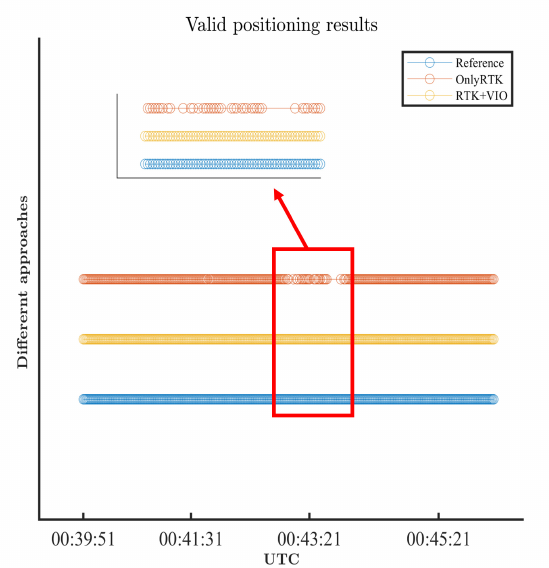
Figure 16. Valid positioning